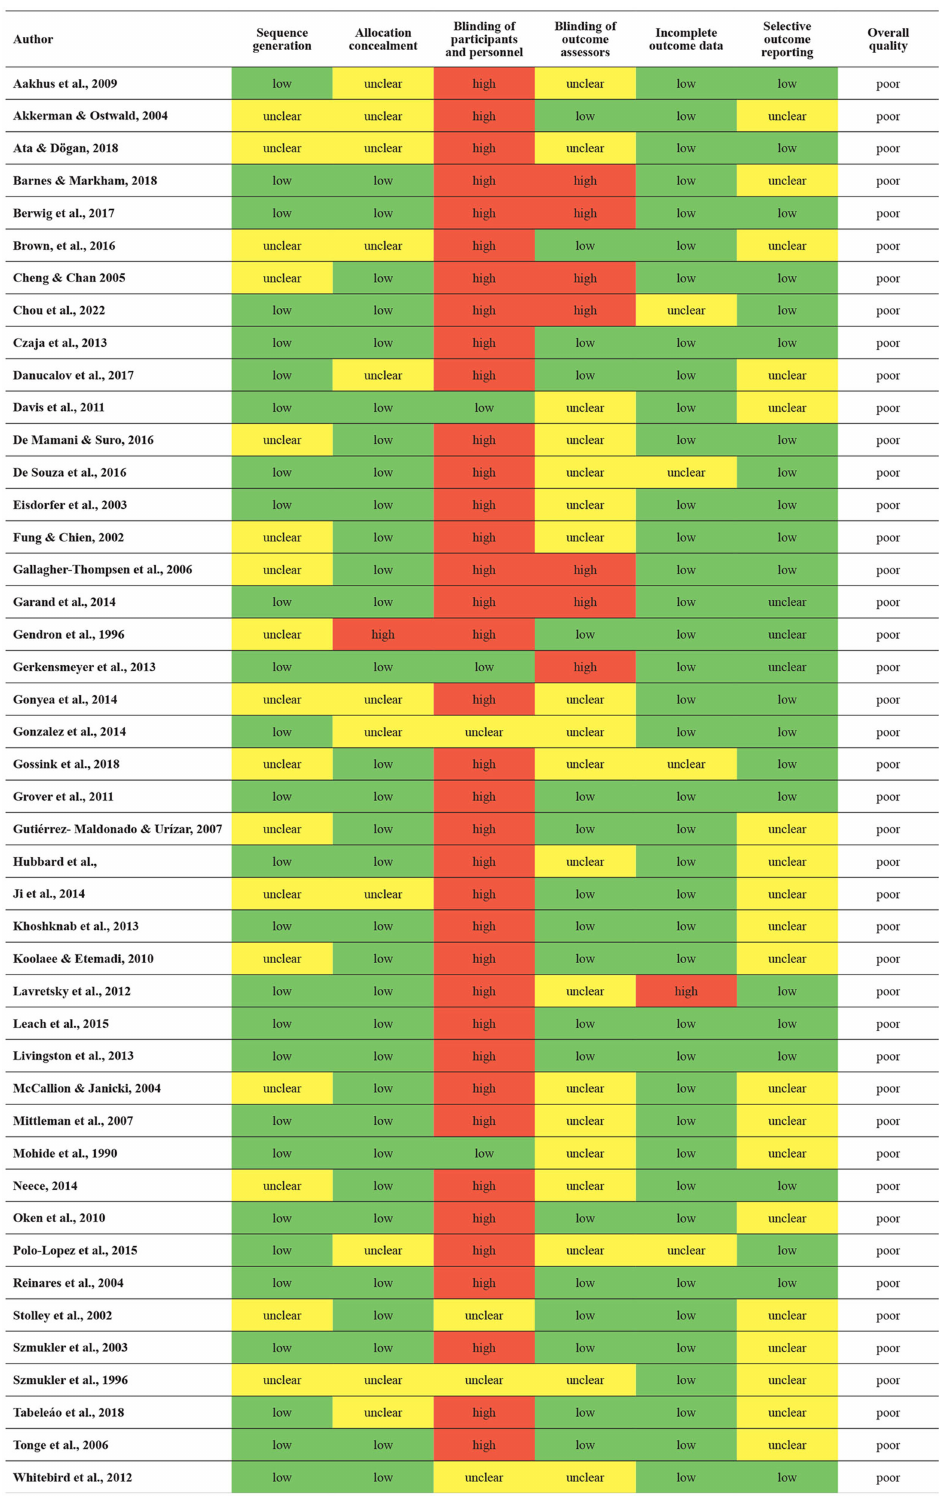
TABLE 3 Cochranes Risk of